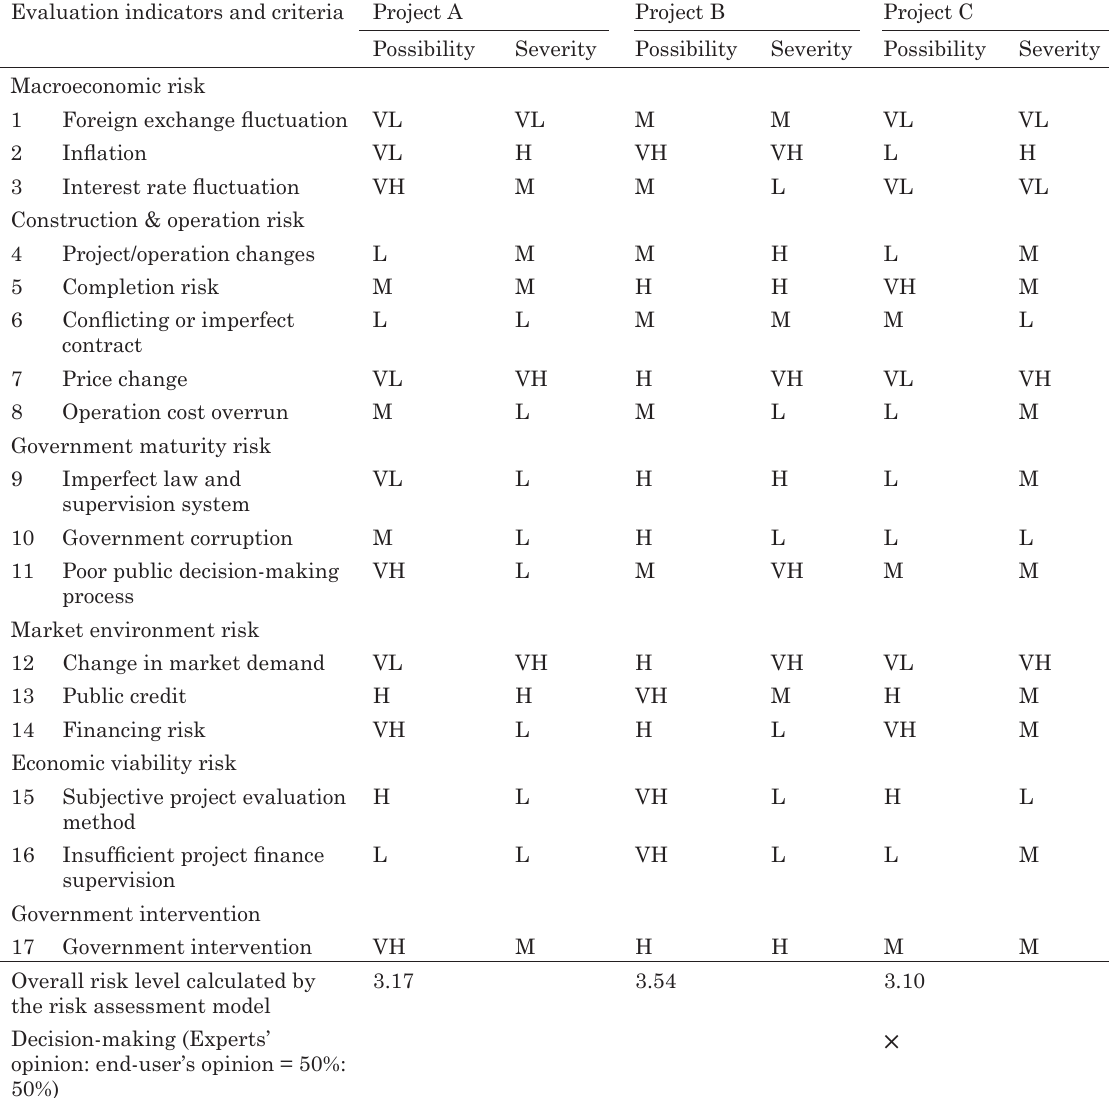
table 8. risk perception for evaluation indicators of three selected PPP projects evaluation indicators and